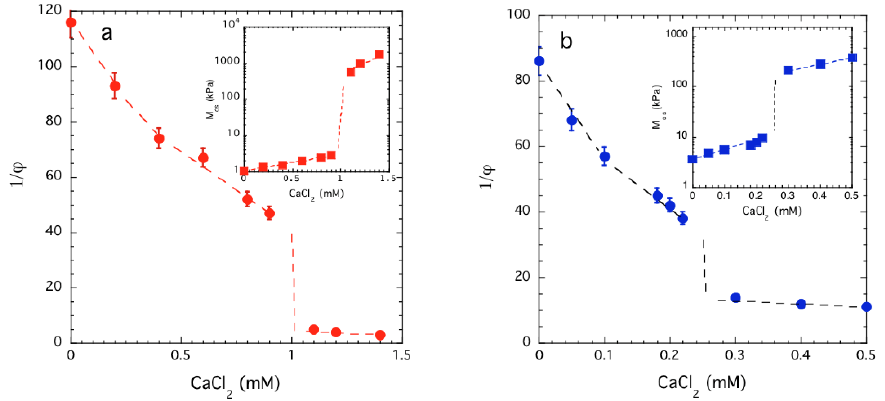
Figure 4. Dependence of the equilibrium swelling ratio (1/ ϕ ) of PAA ( a ) and DNA gel ( b ) in 40 mM NaCl as a function of the CaCl 2 concentration. Insets: Variation of the longitudinal osmotic modulus M os calculated from Equation (9) on the CaCl 2 concentration. Dashed lines are guide to the eyes. The uncertainties are the standard deviation based on three repeated measurements.